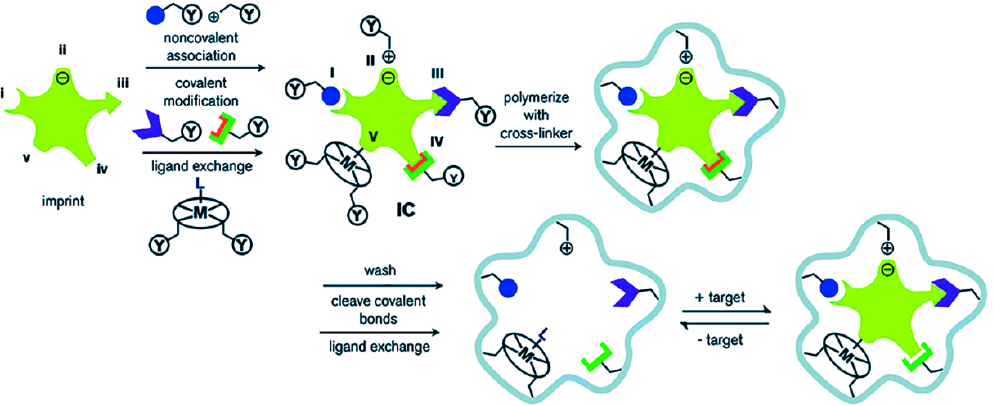
Figure 1. Schematic diagram of the molecular imprinting process: ( I ) non-covalent, ( II ) electrostatic/ionic, ( III ) covalent, ( IV ) semi-covalent, and ( V ) coordination to a metal center (Reprinted with permission from [22]. Copyright 2014 Royal Society of Chemistry).